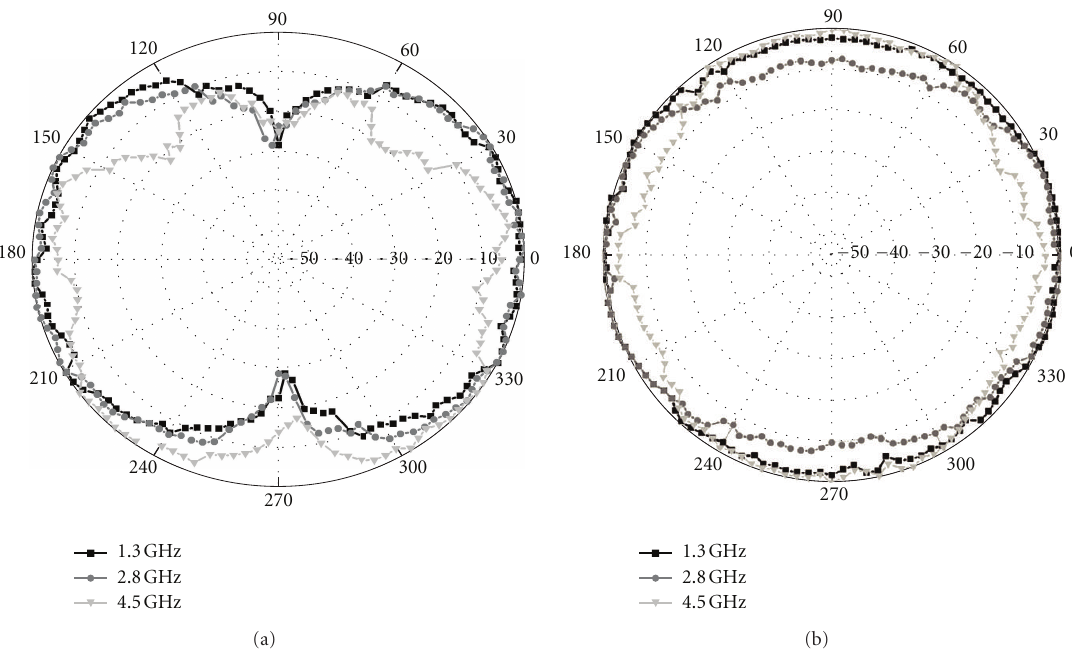
Figure 4: Measured copolarized far-field radiation patterns: (a) E pane, (b) H